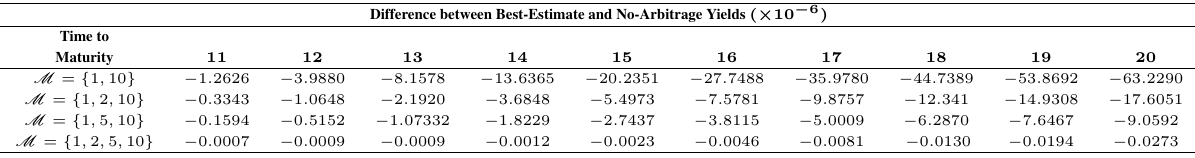
Table 6. Differences between the best-estimate and the no-arbitrage yields for different sets of traded bonds, for Parameter set